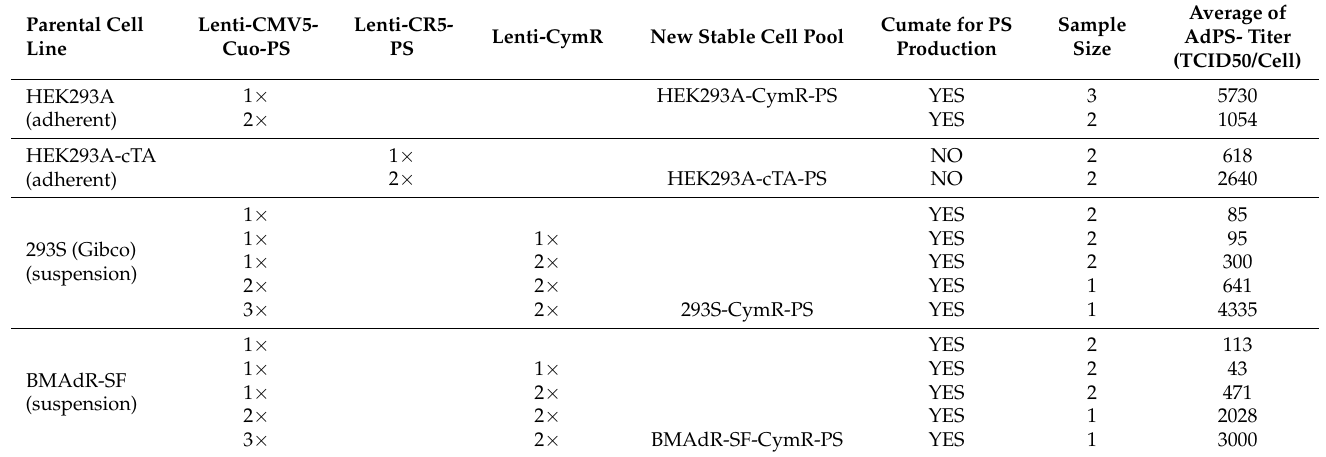
Table 1. Stable cell pools generated by lentiviruses. The parental cell lines were transduced 2 to 5 times with different lentiviruses expressing the PS gene or repressor CymR, as indicated. The production of AdPS- was measured in each pool by the TCID 50 assay in duplicate and specific productivity was expressed as the TCID 50 /cell. The average of the TCID 50 assay titer is presented. Only one pool in each category with the highest titer was identified with the indicated designation and used for subsequent experiments. Numbers in the 2nd to 4th columns represent the number of transfections with each